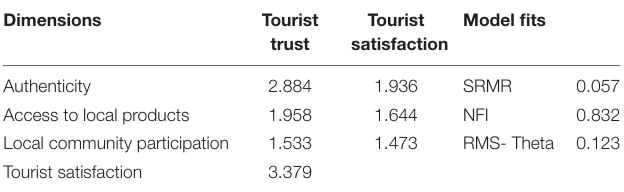
TABLE 4 | Collinearity and model fits.